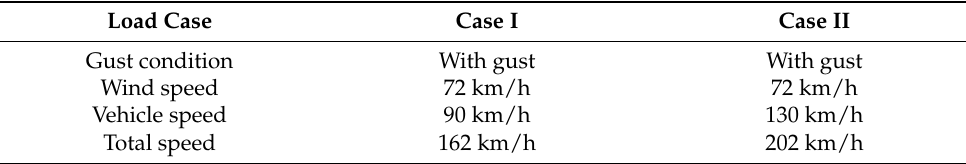
Table 3. Load case for structural